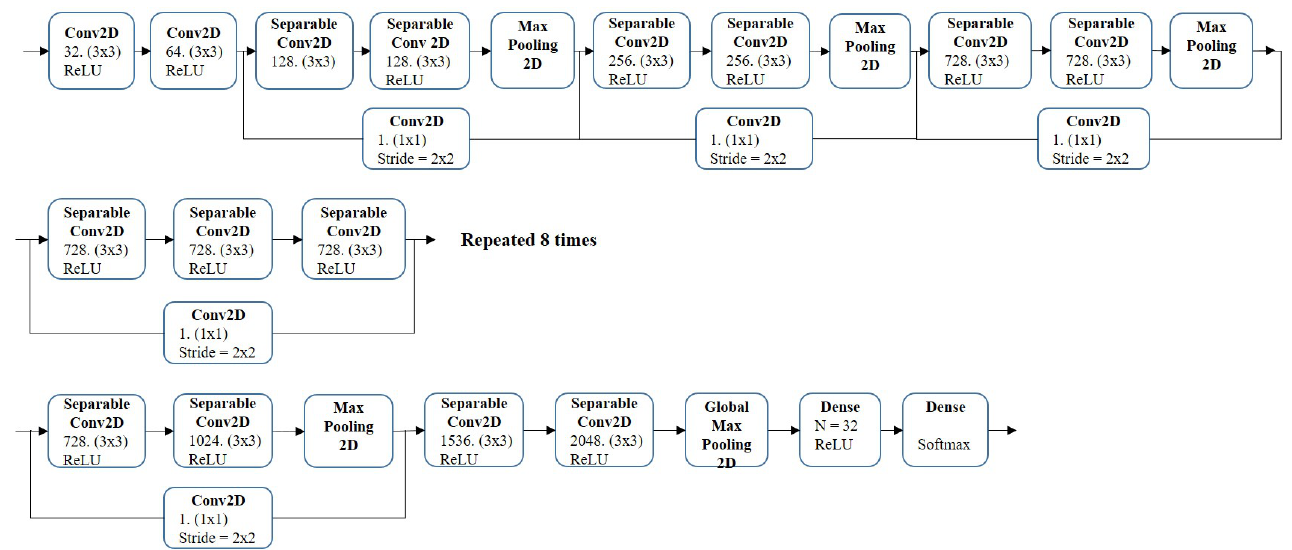
Figure 7. The network architecture of